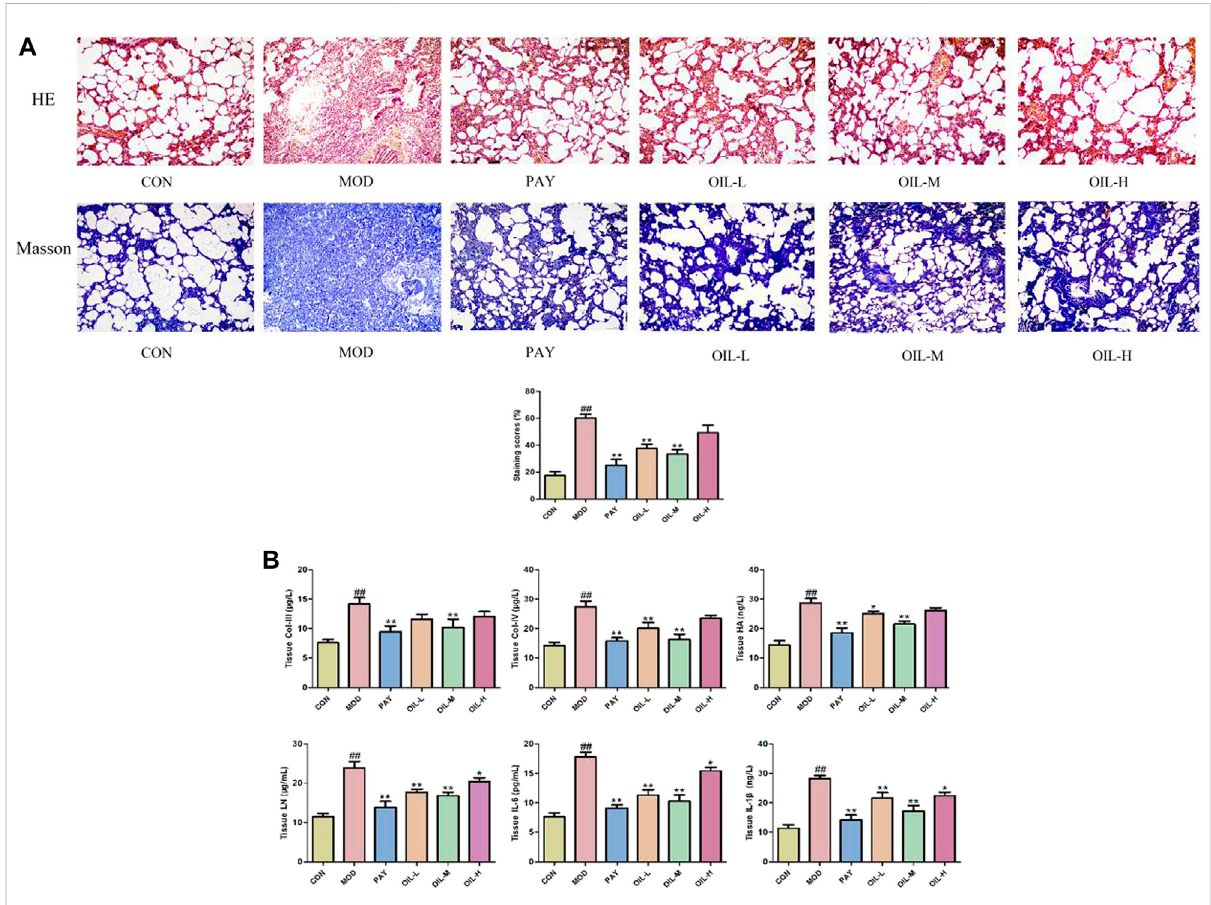
FIGURE 1 The effect of A. mongolica oil on histopathology of pulmonary fi brosis rats (HE, Masson×100) (A) . Effects of A. mongolica oil on tissue biochemical indices in rats with pulmonary fi brosis (B) . ** p < 0.01,* p < 0.05 vs. model group; ## p < 0.01, # p < 0.05 vs. control group.